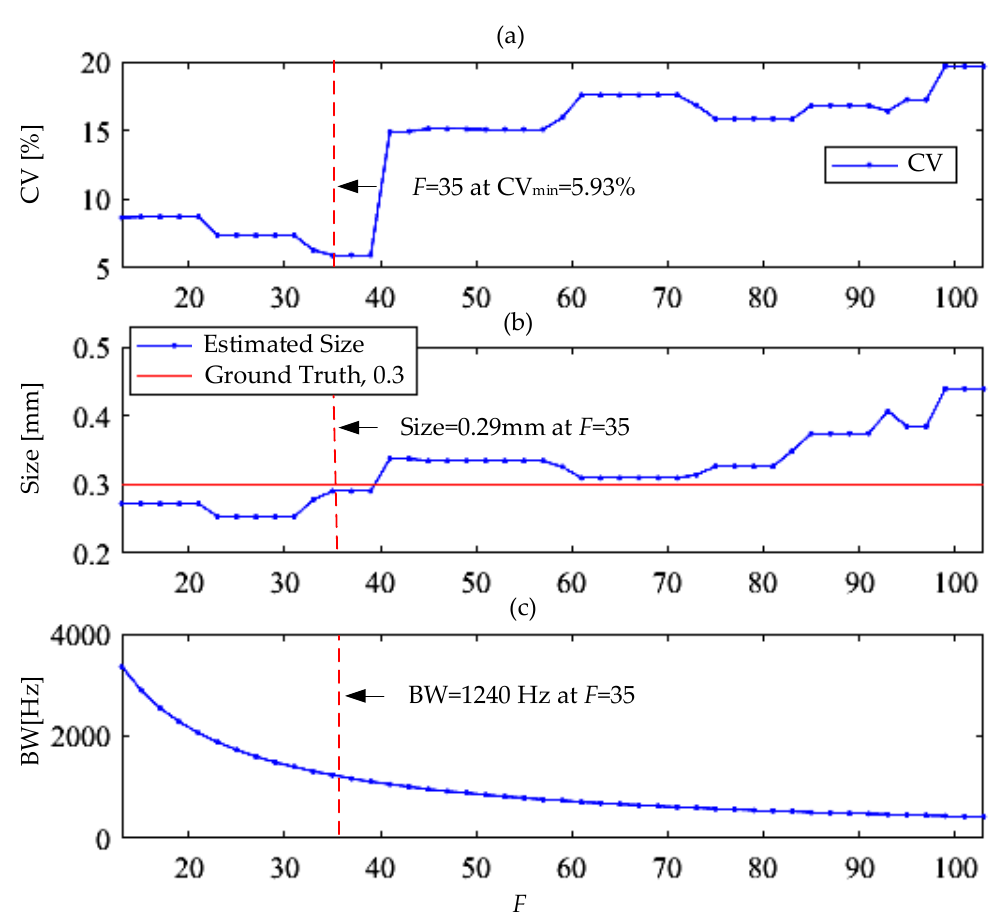
Figure 10. Example of jerk-based quantification for dataset ID 2 and spall ID 1.